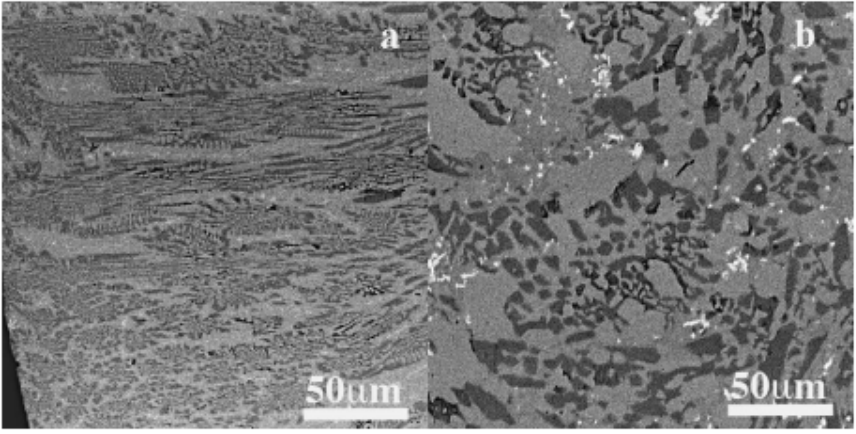
Figure 3. SEM-BEI micrographs of the cross section of Fe processed in water-cooled copper boat. ( a ) Columnar and equiaxed eutectic patterns of the border area; ( b ) Coarse grained eutectic in the center of the